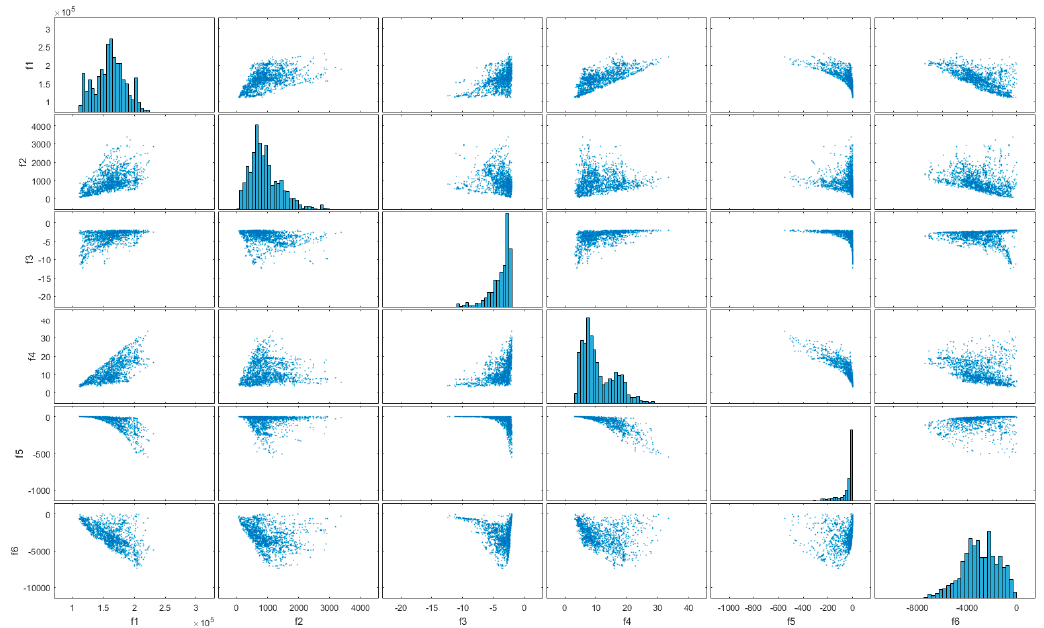
Figure 12. Set of Pareto optimal solutions presented in the form of a scatter matrix plot for the 1st variant of optimization task.